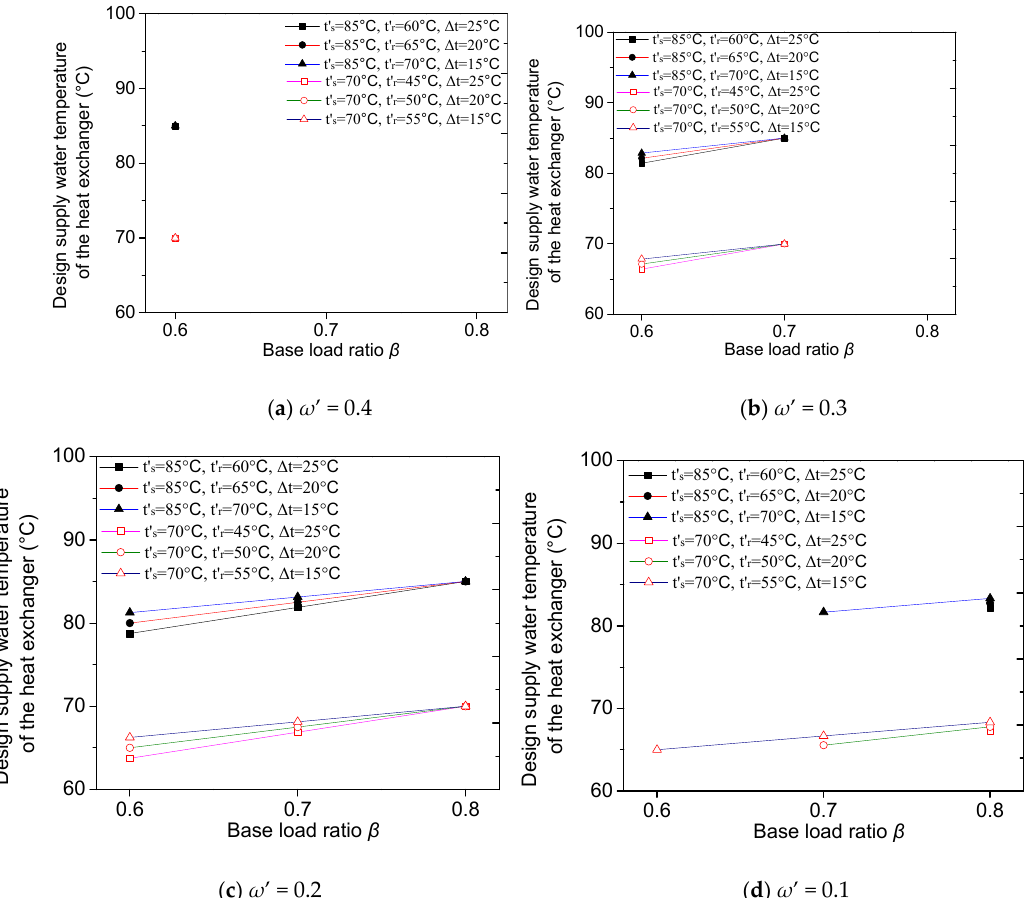
Figure 5. Variation of the design supply water temperature of the heat exchanger ( t (cid:48) ) with di ff erent network temperature levels, base load ratio ( β ) and design peak shaving flow ratio ( ω (cid:48) ) for parallel connection.